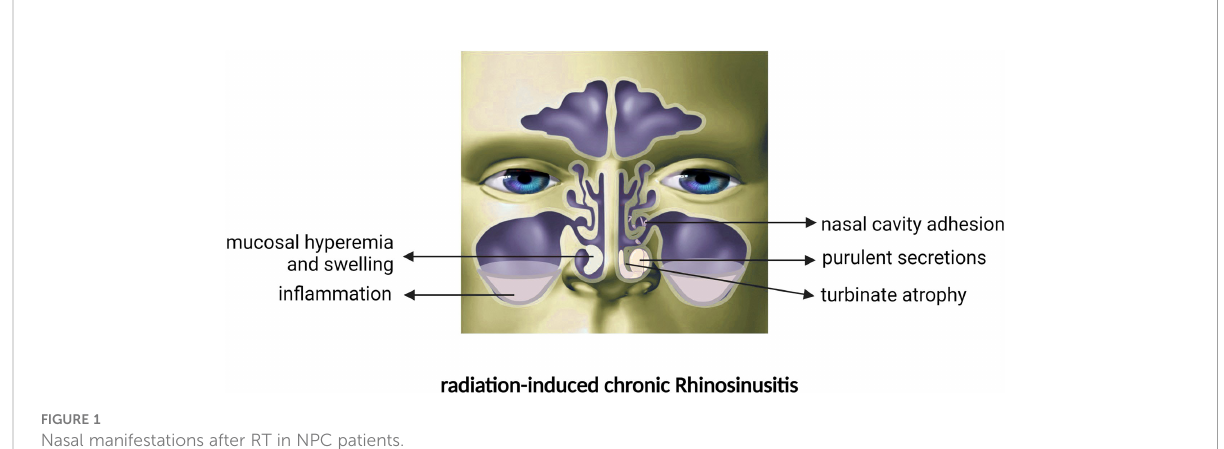
FIGURE 1 Nasal manifestations after RT in NPC